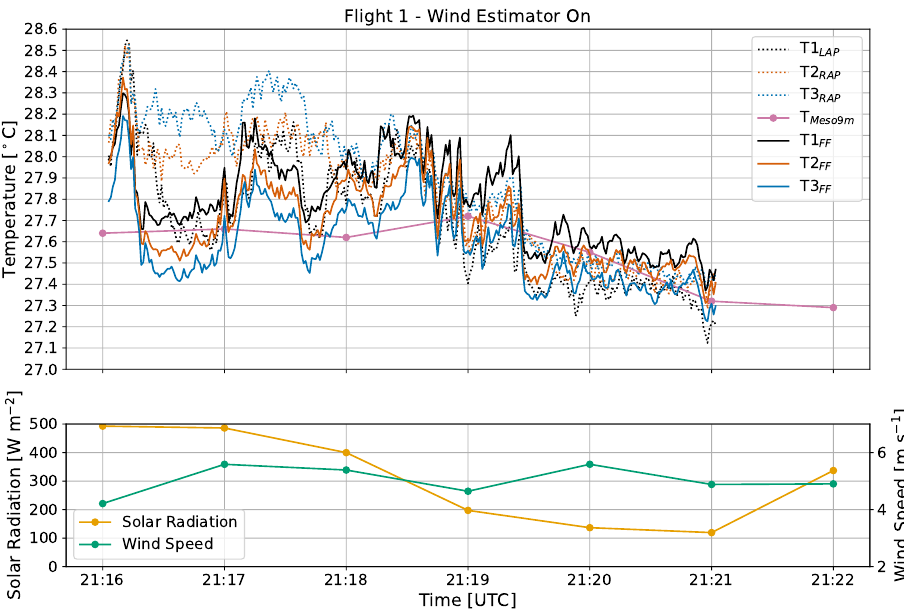
Figure 6. Time series of temperature [ ◦ C], solar radiation [W m − 2 ], and wind speed [m s − 1 ] from flight 1. The wind estimator was on, and the CopterSonde was oriented directly into the oncoming wind. In the top figure, temperatures from the front fan setup are in solid lines, whereas measurements from the arm propellers are dotted. Measurements from the Mesonet tower collected at 1-min intervals and plotted with connected solid circles.